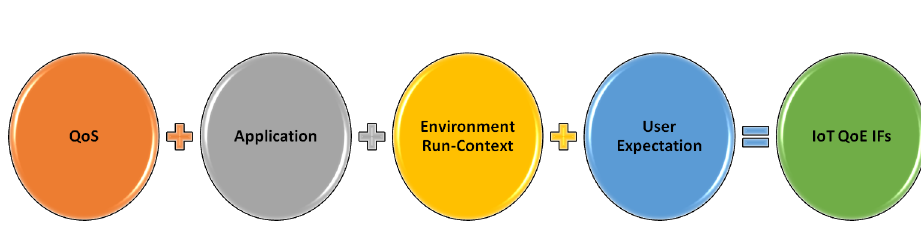
Figure 5. QoE IFs in the IoT context